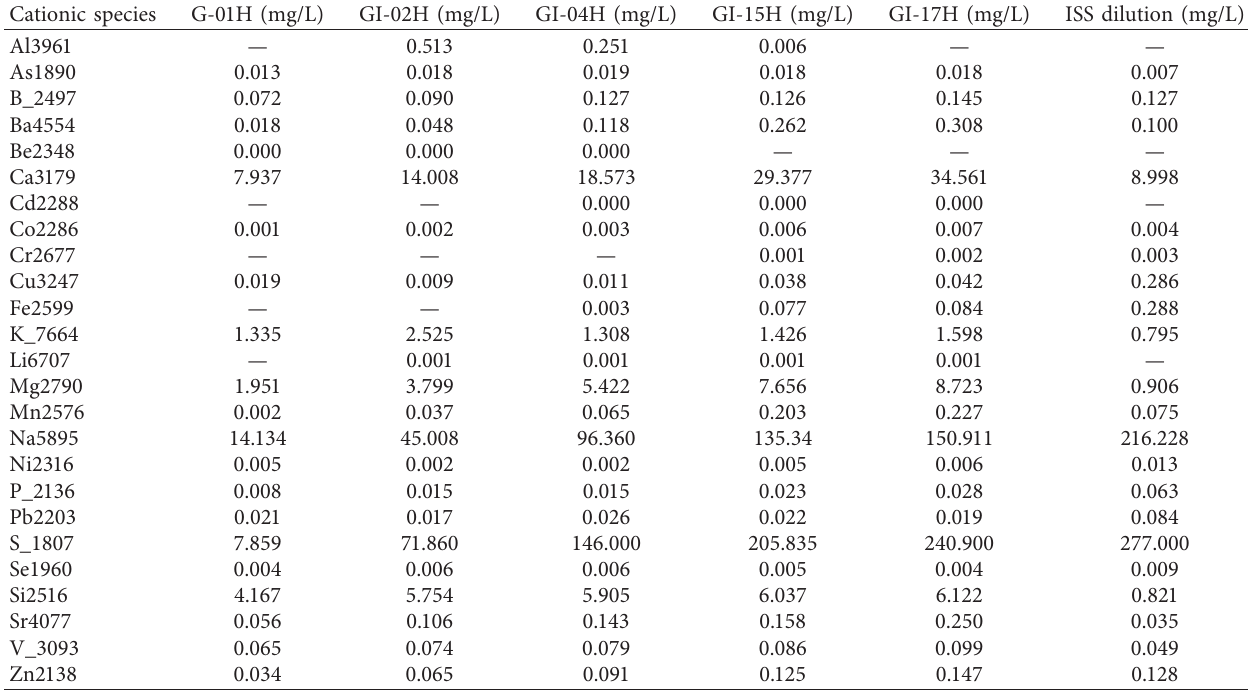
Table 7: Analysis of cation concentration of exudate.